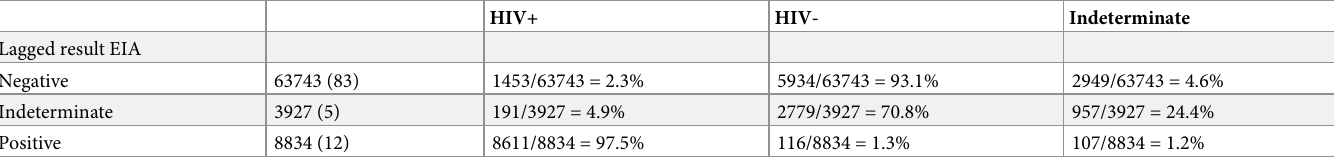
Table 3. The prevalence of transitioning from HIV negative, positive or indeterminate to HIV negative, positive or indeterminate in subsequent follow-up serologi- cal tests. HIV+